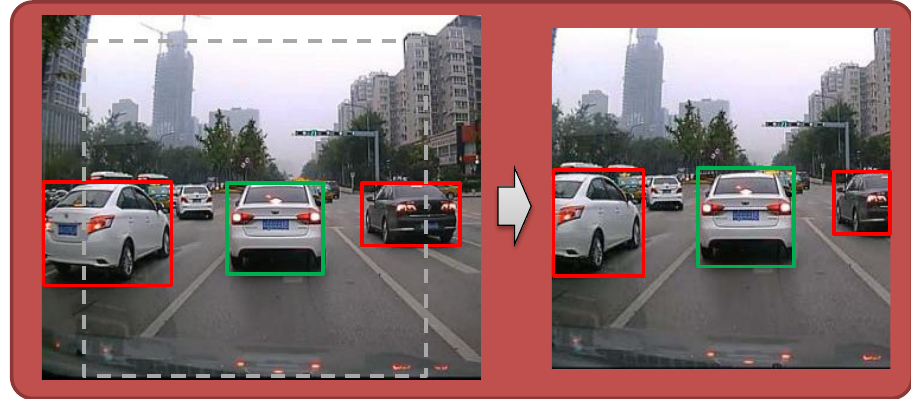
Figure 3. A training sample of vehicle detection and an example of its random cropping result.